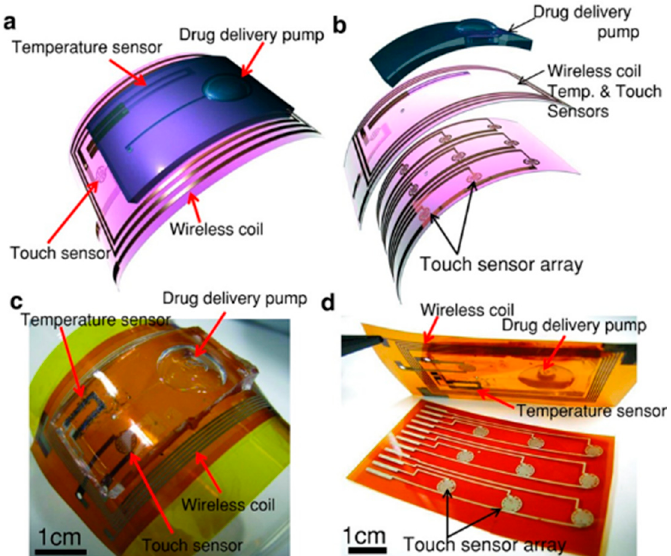
Figure 8. Smart bandage with touch and temperature sensors, a wireless coil, and a drug delivery pump. Schematics with ( a ) and without ( b ) a capacitive touch panel. Photos with ( c ) and without ( d ) a capacitive touch panel. Reproduced with permission from Ref. [181]. Copyright © 2014 WILEY-VCH Verlag GmbH & Co. KGaA, Weinheim.